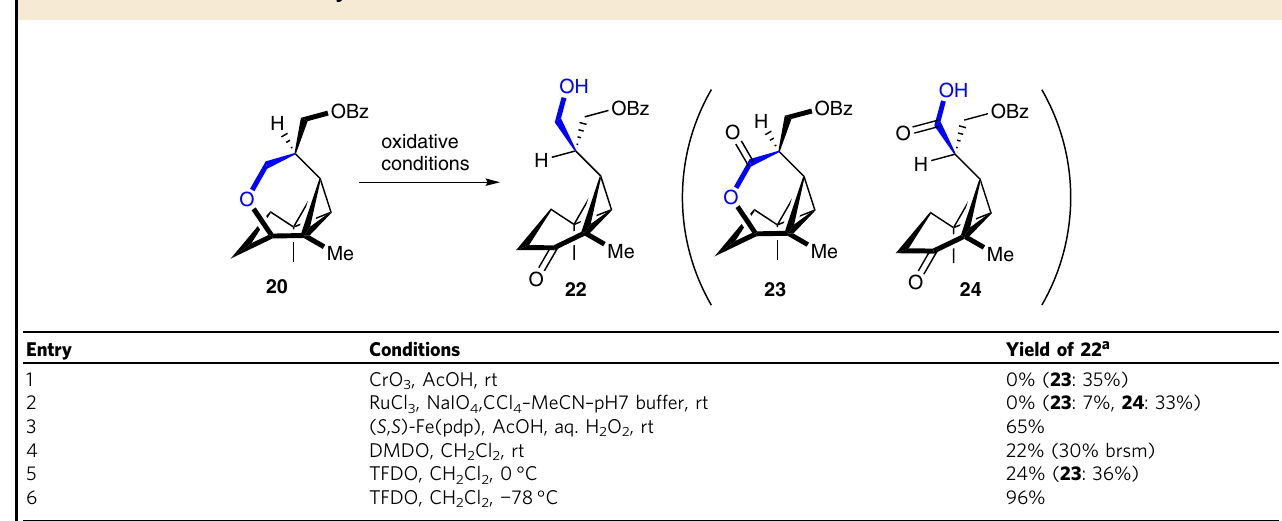
Table 3 C – H oxidation of tetrahydrofuran